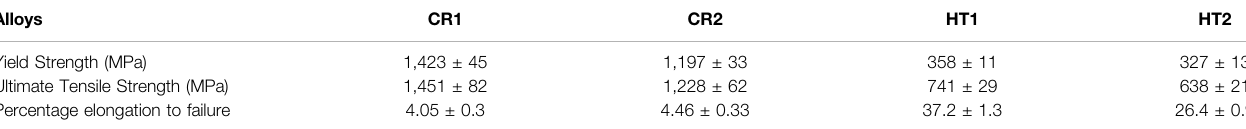
TABLE 1 | Yield Strength (YS), Ultimate Tensile Strength (UTS), and Percentage elongation to failure for CR1, CR2, HT1, and HT2 alloys. Alloys CR1 CR2 Yield Strength